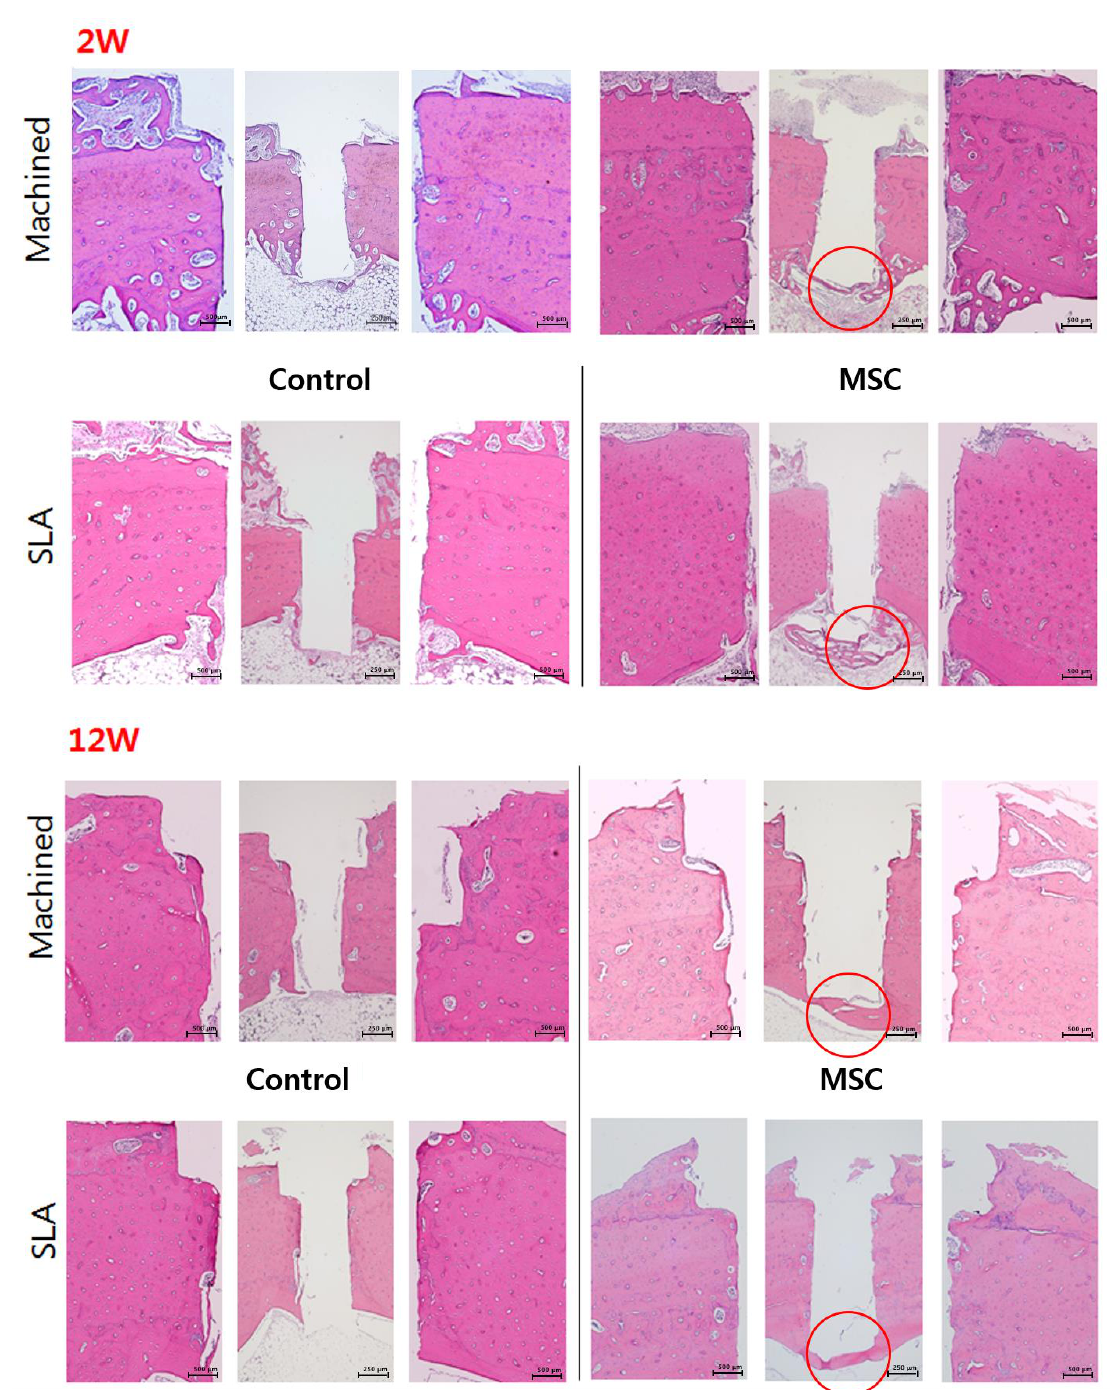
Figure 7. Light-microscopy views of the control group (without d-hMSCs) and the d-hMSCs group sacrificed at 2 and 12 weeks post-surgery (hematoxylin and eosin (H&E) stain, original magnification × 50, × 100; red circle indicates defect Figure 8. Histomorphometric analysis light-microscopy views of the control group (without d-hMSCs) and the d- hMSCs group sacrificed at 2 and 12 weeks post-surgery. *: p < 0.05